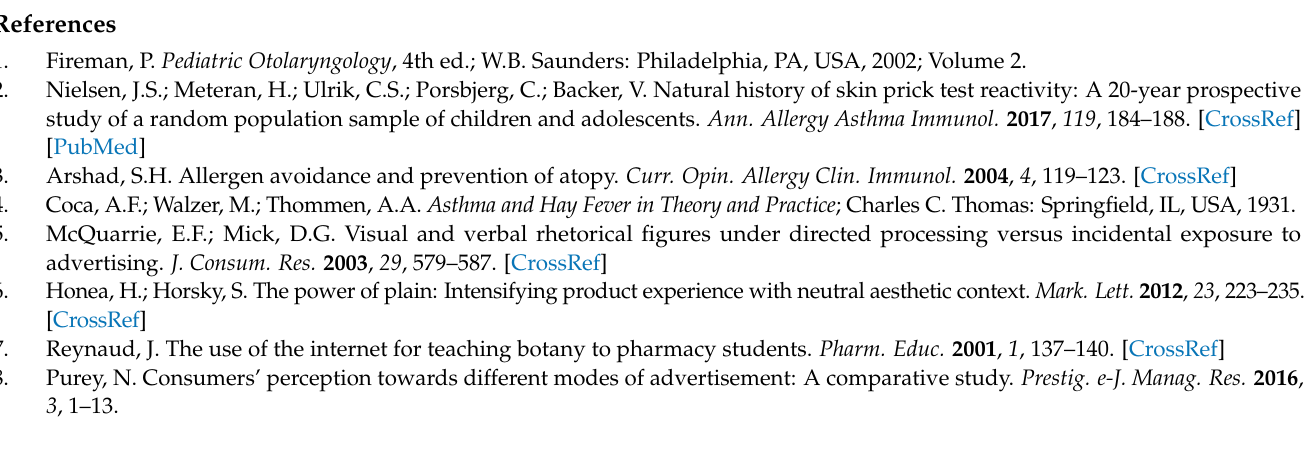
Table S2: The process of the formal analysis of